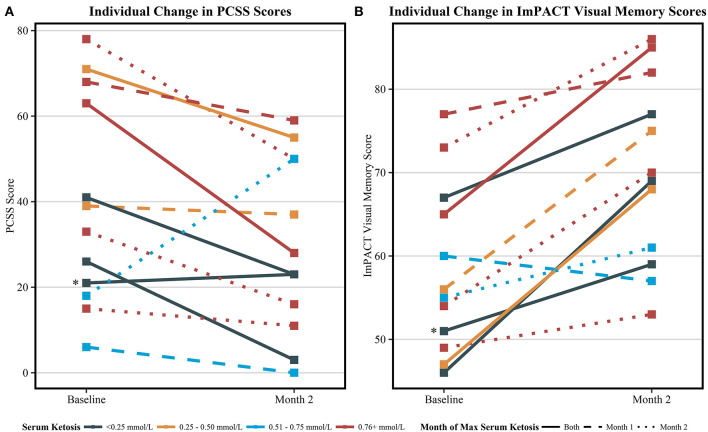
Individual change in symptom and visual memory scores among all completing participants (n = 12). (A) The individual change in the post-concussion symptom scale (PCSS) from baseline to 2 months. Decreasing scores indicate improvement in self-reported symptoms. (B) The individual change in ImPACT visual memory scores from baseline to 2 months. Increasing scores indicate improvement in tested visual memory. Serum ketosis levels were determined by peak measured serum BHB. Different line types indicate the month which peak ketosis was reached, a solid line indicating both month 1 and 2, a dashed line indicating month 1, and a dotted line indicating month 2. One participant (*) was considered not compliant with the KD and did not produce urine ketones as indicated by the urine ketone record nor had elevated serum BHB at any study visits. This participant's symptom score slightly worsened and verbal memory score slightly improved from at the end of the study. The other two participants that did not register elevated BHB at study visits recorded trace ketone production via urine ketone records during the course of the study.